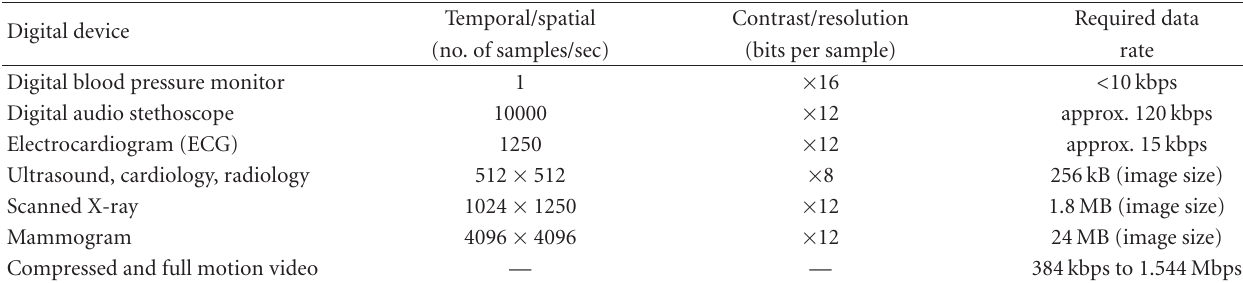
Table 2: Data rates for typical telemedicine devices